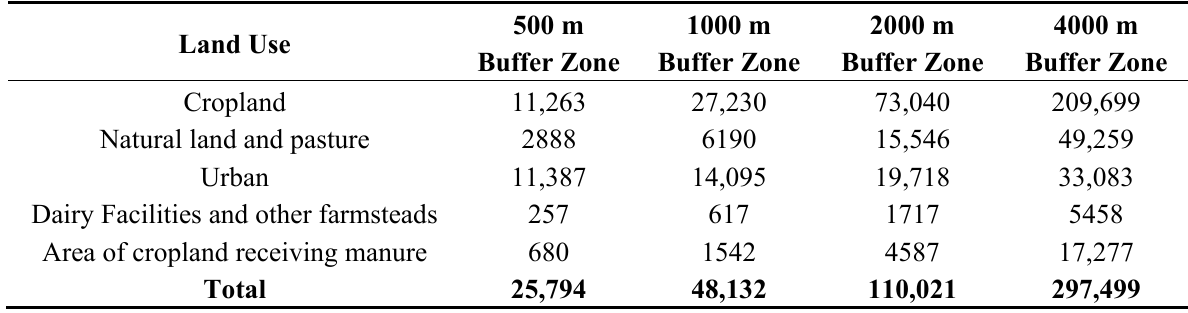
Table 3. Land area (ha) within each buffer zone.